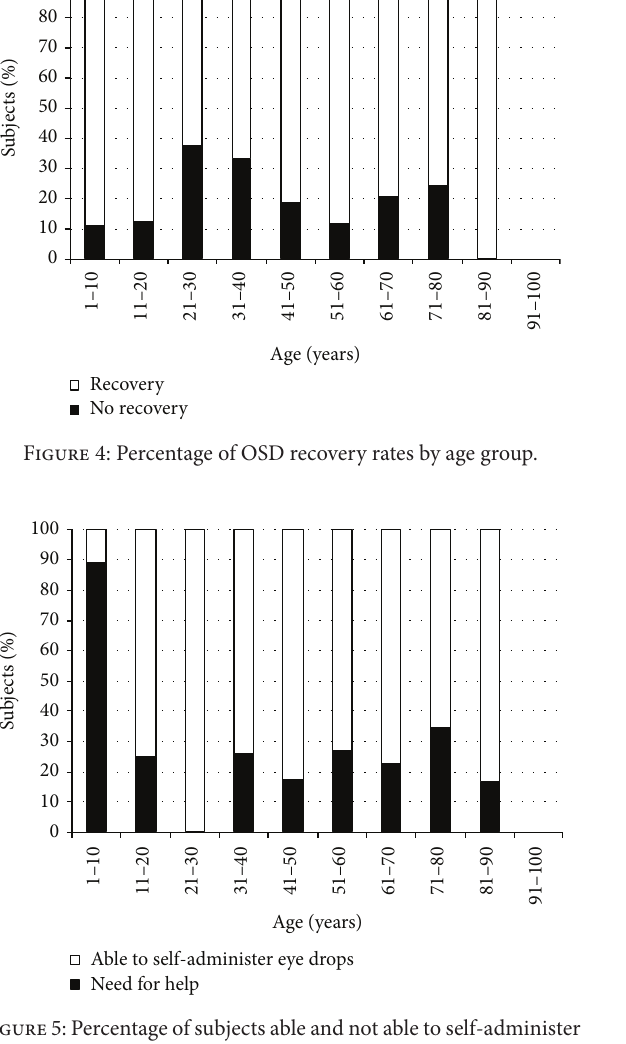
Figure 7: Therapy